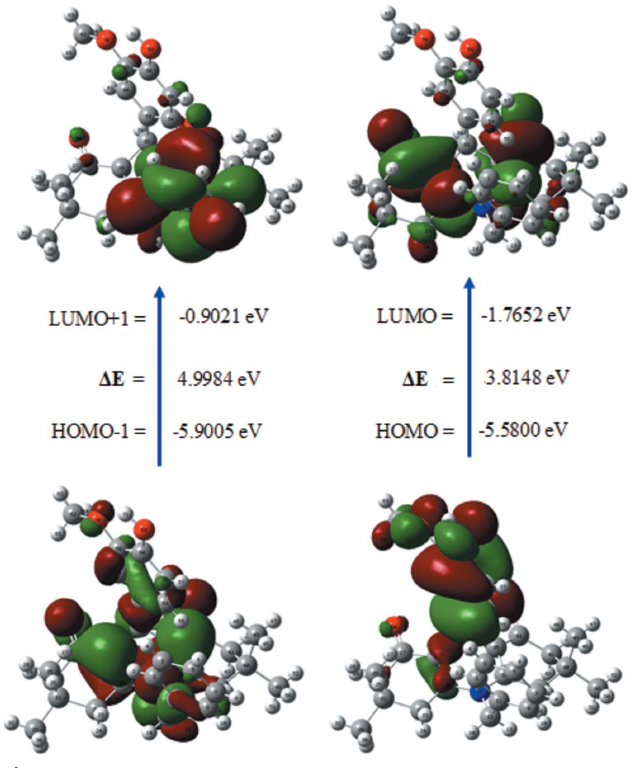
Figure 6 The frontier molecular orbitals of the title molecule.